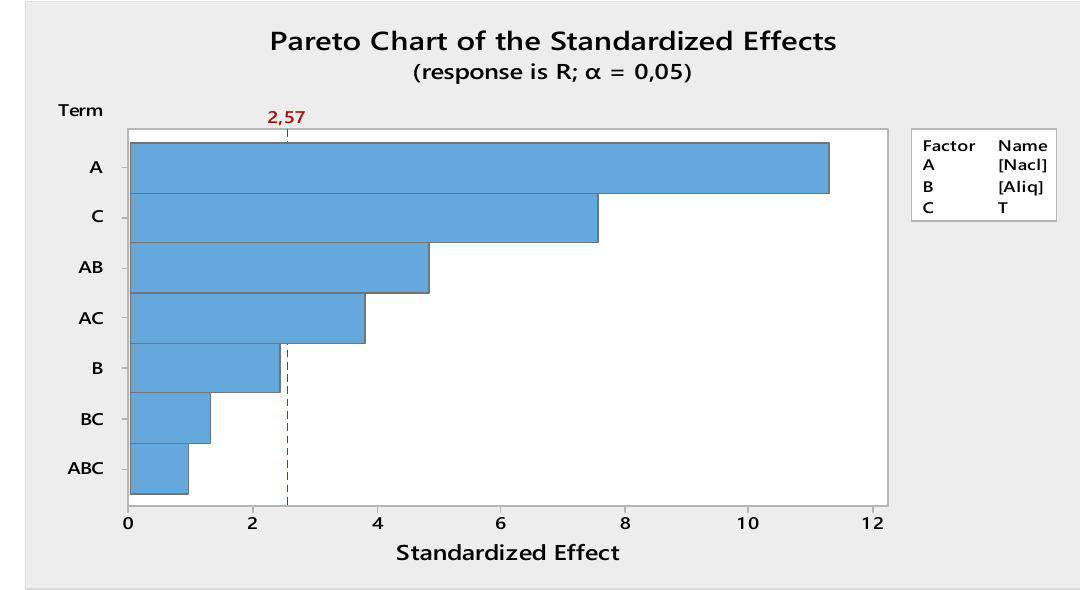
Figure 7. Receiving phase Pareto chart of standardized effect.